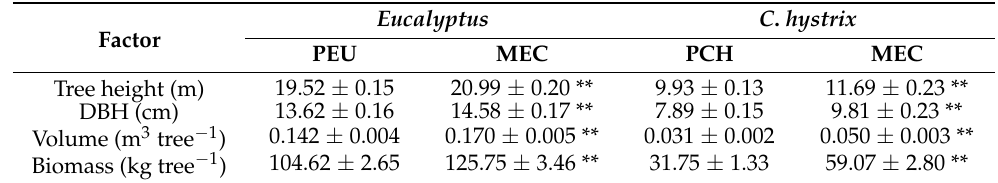
Table 4. Tree height, diameter at breast height (DBH), volume, and biomass of eucalypt trees and Castanopsis hystrix growing in mono-specific and mixed-plantation types.